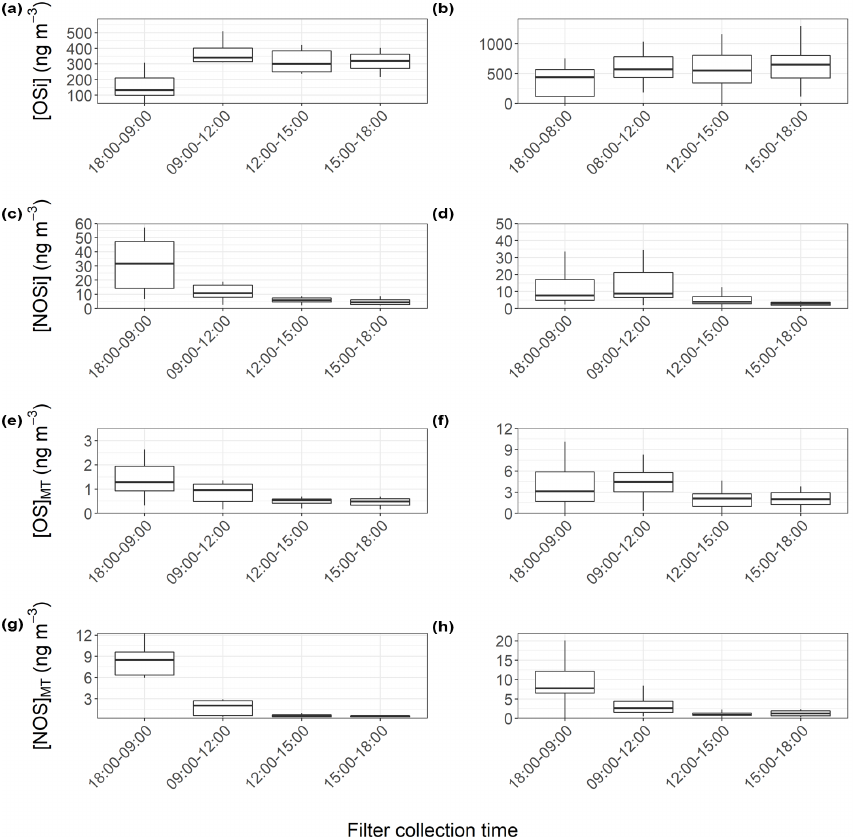
Figure 7. Partial diurnal variations from the binned concentrations of OSi, NOSi, OS MT , and NOS MT concentrations at each filter collection time across the pre- (a, c, e, g) and post-monsoon (b, d, f, h) campaigns. The lower and upper parts of the box represent the 25th and 75th percentiles, with the upper and lower lines extending no further than 1.5 times the interquartile range of the highest and lowest values within the hinge, respectively. Only species identified in more than 40% of the samples for each campaign were included.